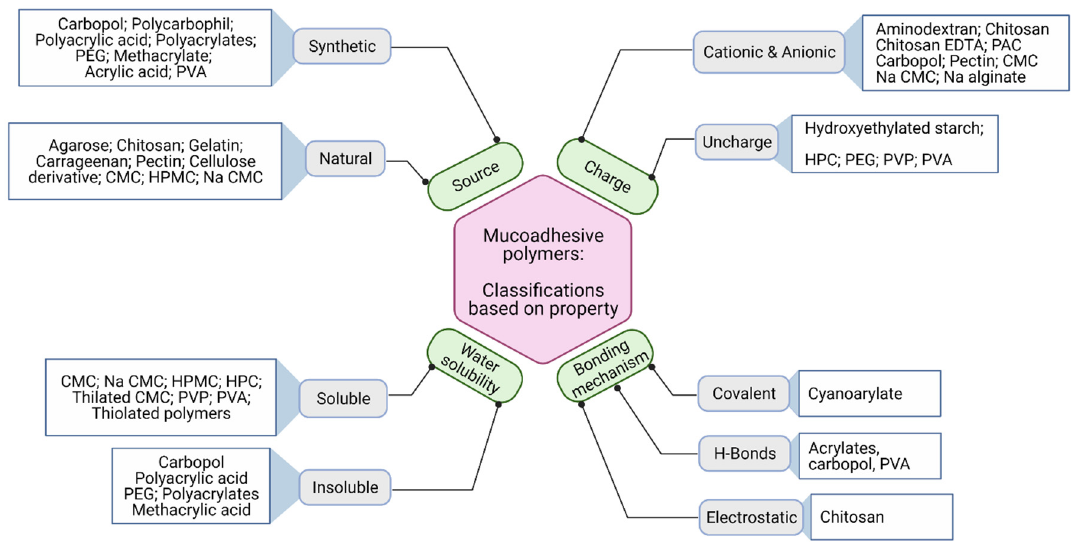
Figure 8. Classification of mucoadhesive polymers (Reprinted with permission from Mansuri et al. 2016 [92]).